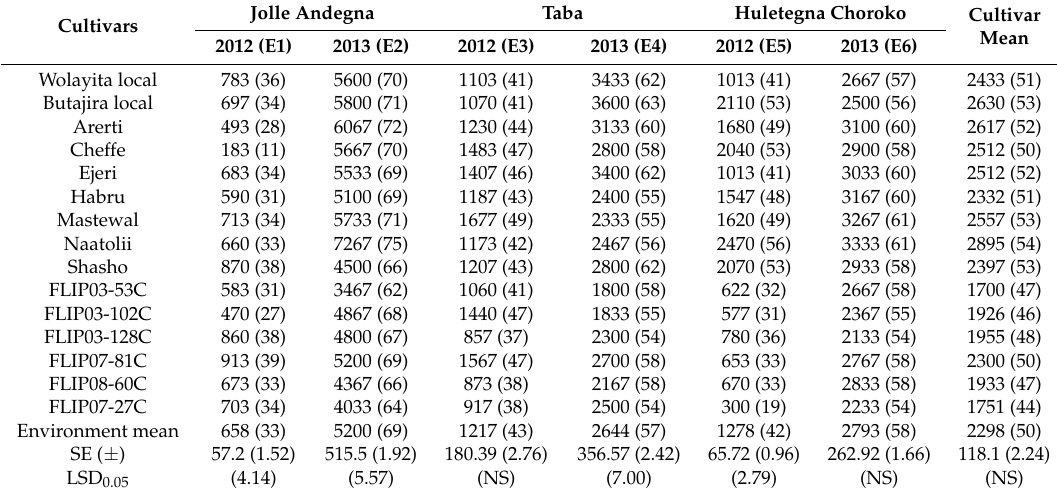
Table 6. Grain yield (kg · ha − 1 ) of 15 chickpea cultivars and breeding lines tested under zinc fertilized soil across three locations in southern Ethiopia during the 2012 and 2013 growing